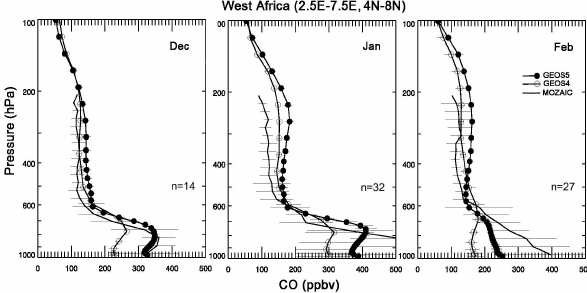
Fig. 22. Monthly mean CO profiles for December, January and February. MOZAIC aircraft profiles (solid line) are averages for 2002–2007 (primarily 2002–2004) over western Africa (Lagos, Abidjan, and Accra, ∼ 95% from Lagos). n represents the numbers of observations at 520hPa ( n =14, 32, 27 for December, January and February). Model CO profiles are averages for 2005-2006 for the grid (2.5 ◦ E–7.5 ◦ E, 4 ◦ N–8 ◦ N) for GEOS-4 (open circles) and GEOS-5 (solid